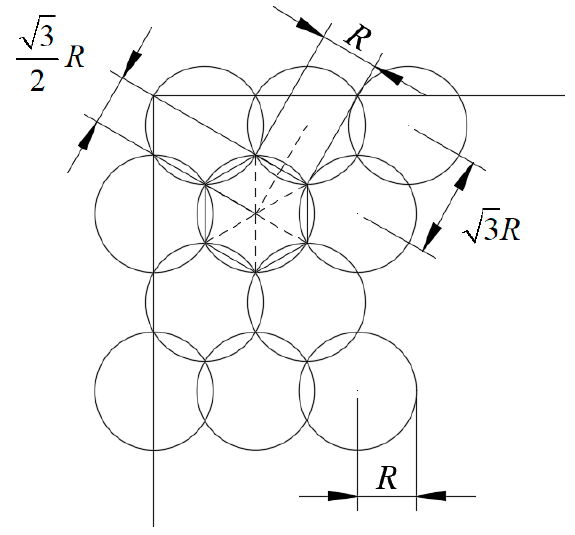
Figure 3. The ideal deployment scheme when using equal circles to cover, where the center distance of each two circles is 3 R , and the definition of S s is shown.